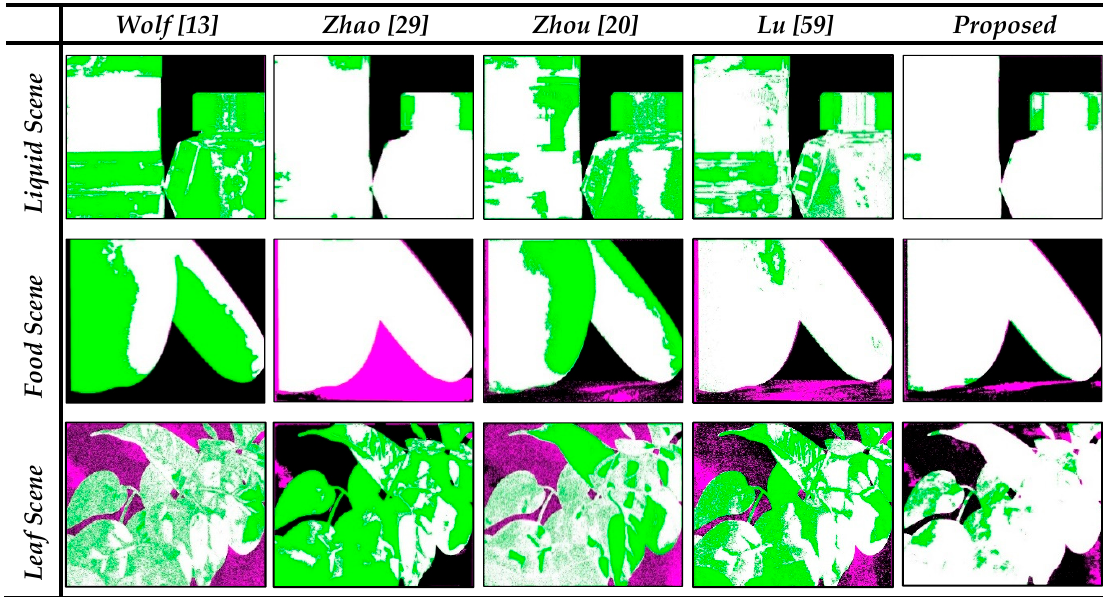
Figure 13. Comparison of segmentation errors of three scenes in the MSPI dataset. Table 4. Analysis of computational times of di ff erent techniques for three scenes in the MSPI